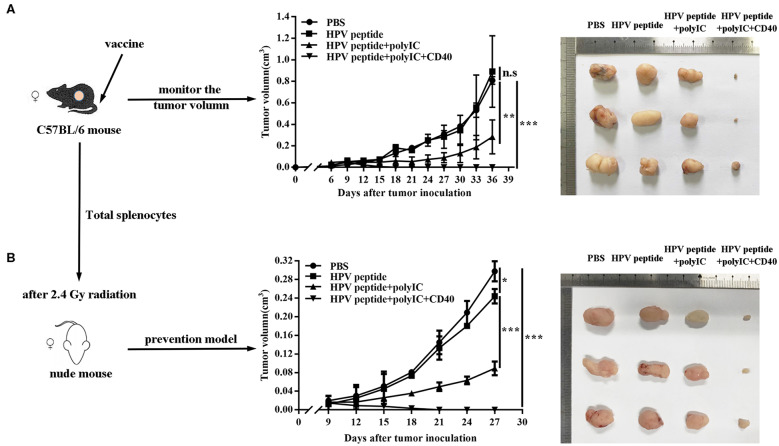
Anti-tumor effects induced by different immunization. (A) Mice (n = 3 per group) were inoculated (s.c.) with 1 × 106 TC-1 cells and vaccinated (i.v.) 6 days later with PBS, HPV16 E7 peptide alone, peptide plus polyIC, peptide and polyIC plus αCD40 mAb. (B) In the preventive model, nude mice after 2.4 Gy radiation were injected with 10 million of total splenocytes of the immunized mice when TC-1 tumor appeared. Tumor growth was measured (two opposing diameters) and recorded once every 3 days. Data shown represent three independent experiments with similar results. *p < 0.05, **p < 0.01, ***p < 0.001, n.s, p > 0.05.